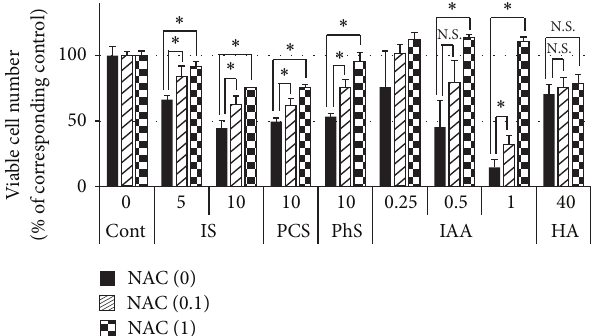
Figure 5: Effect of N-acetyl-L-cysteine (NAC) on uremic solute- induced decrease in viable cell number. Porcine renal tubular cells were treated with NAC (0, 0.1 or 1mmol/L) for 20 minutes and further treated with each uremic solute for 48 hours. Viable cell number was evaluated using Cell Counting Kit-8. Optical density at 450 nm was measured and the values were calculated as percent of the corresponding control. Cont, control; IS, indoxyl sulfate; PCS, p -cresyl sulfate; PhS, phenyl sulfate; HA, hippuric acid; IAA, indoleacetic acid. Data are shown as mean ± S.D. ( 𝑛 = 4 ). Asterisks indicate significant difference each pairs described in this figure ( 𝑃 < 0.01 ). N.S. means nonsignificant difference.